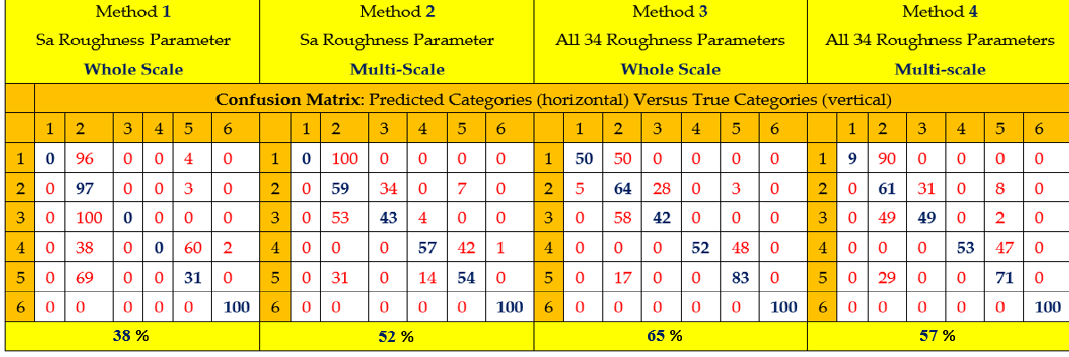
Figure A2. The results of SVM classification for the four methods of roughness characterization.